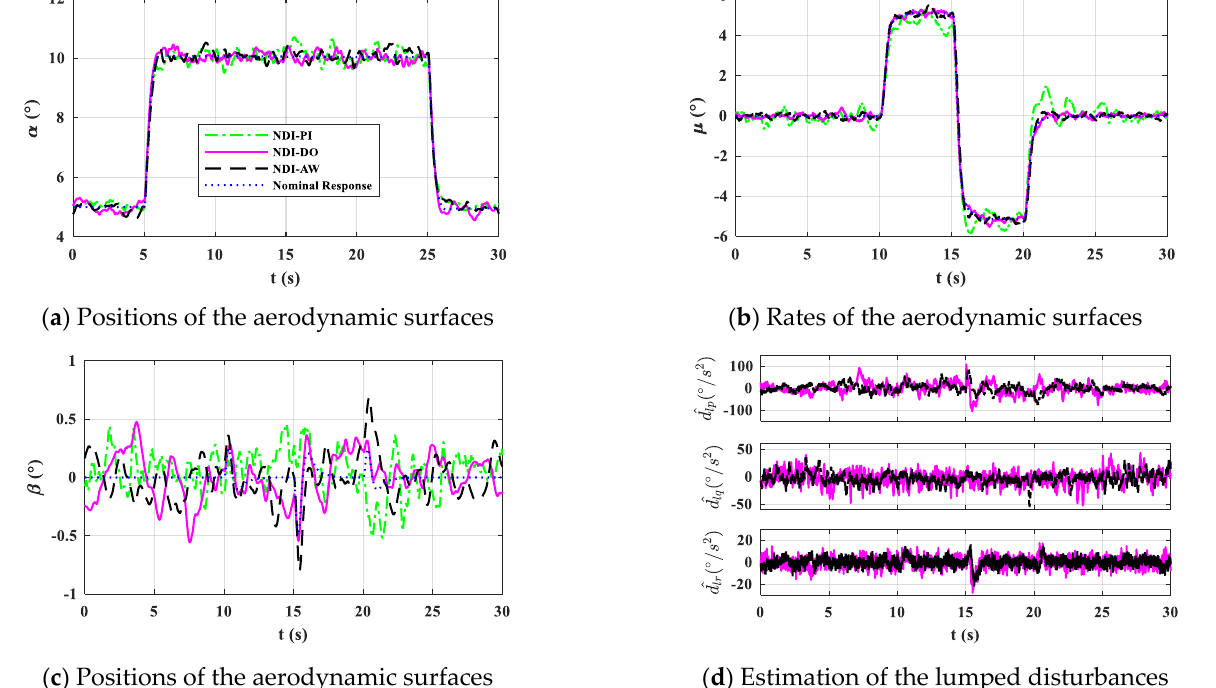
Figure 7. Response of the tailless aircraft model controlled using NDI-PI, NDI-DO, and NDI-AW with the sensor noise.